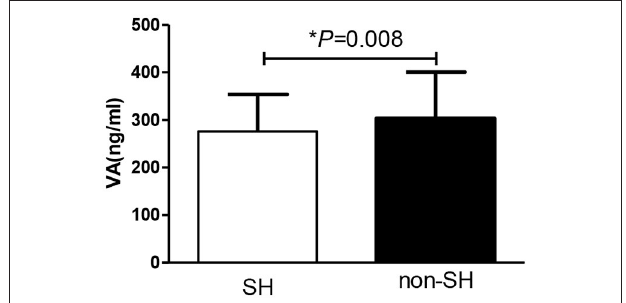
FIGURE 2 | Comparison of VA levels between obese patients with or without